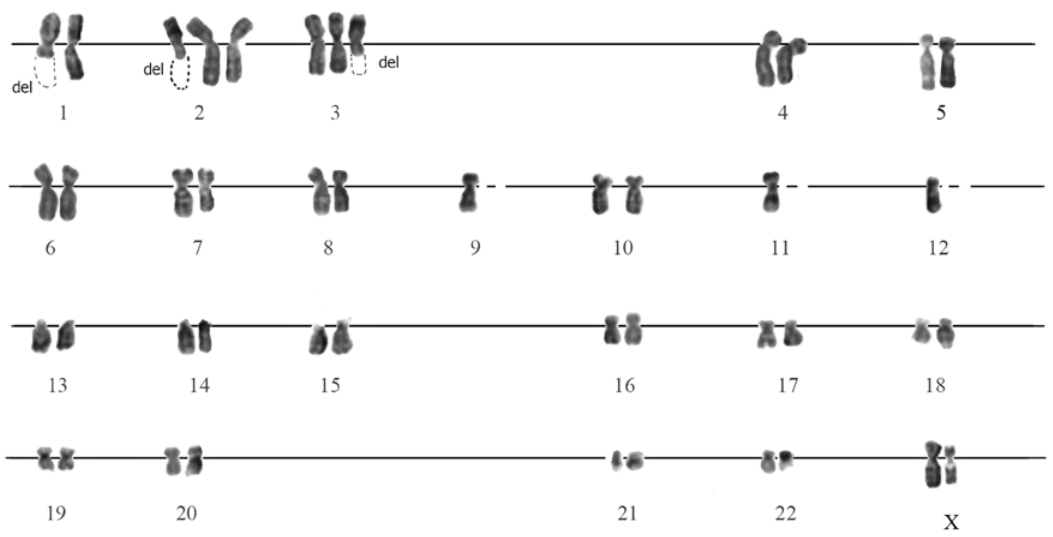
Figure 3. Karyotype of SHS-SP on the passage 6 after SHS (Table S2, metaphase plate N. 26). Totally